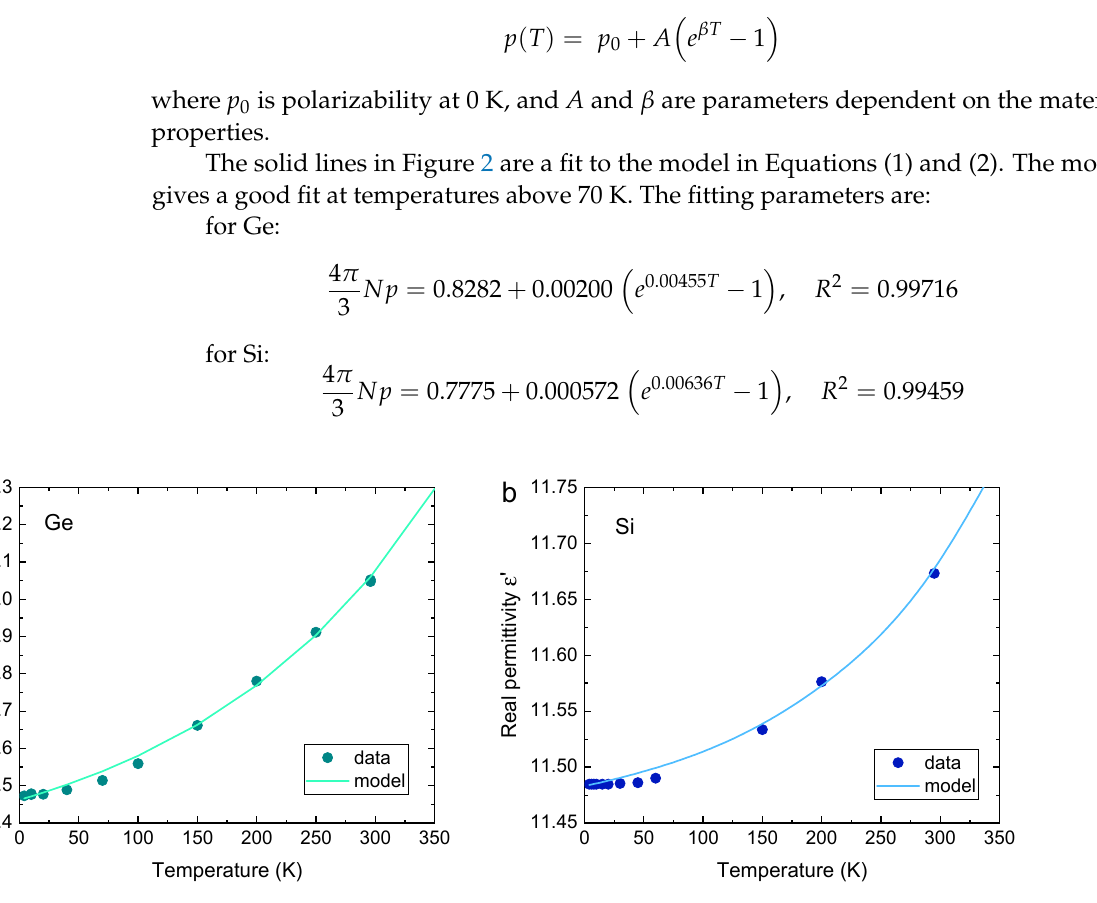
Figure 2. Temperature dependence of the refractive index in ( a ) Ge and ( b ) Si. The refractive index values are mean averages over 4.2–7.7 THz. (The errors, taken as standard deviation of the mean refractive index, are smaller than the size of the symbols.) Solid lines are a fit to Equations (1) and (2); the fitting parameters are given in Equations (3) and (4).